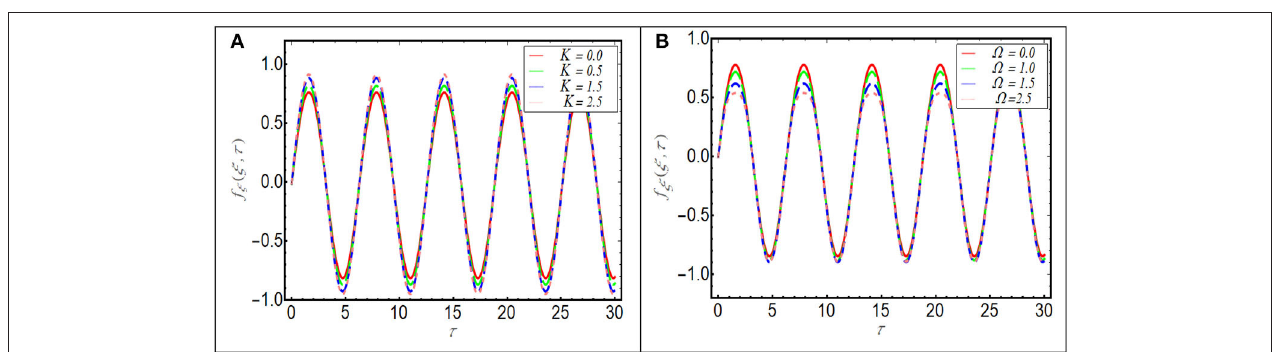
FIGURE 3 | Impact of (A) K (B) (cid:127) on velocity.